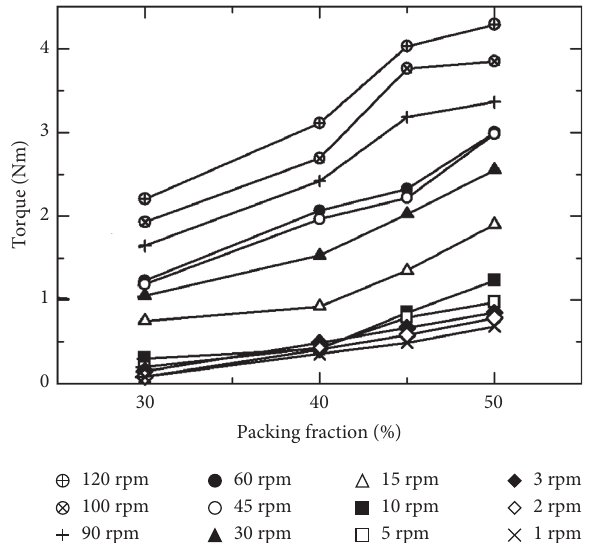
Figure 10: The torque versus packing fraction curve of the rotary damper with no gap between the rotor and cylinder using 3mm diameter particle made from TSE3466.